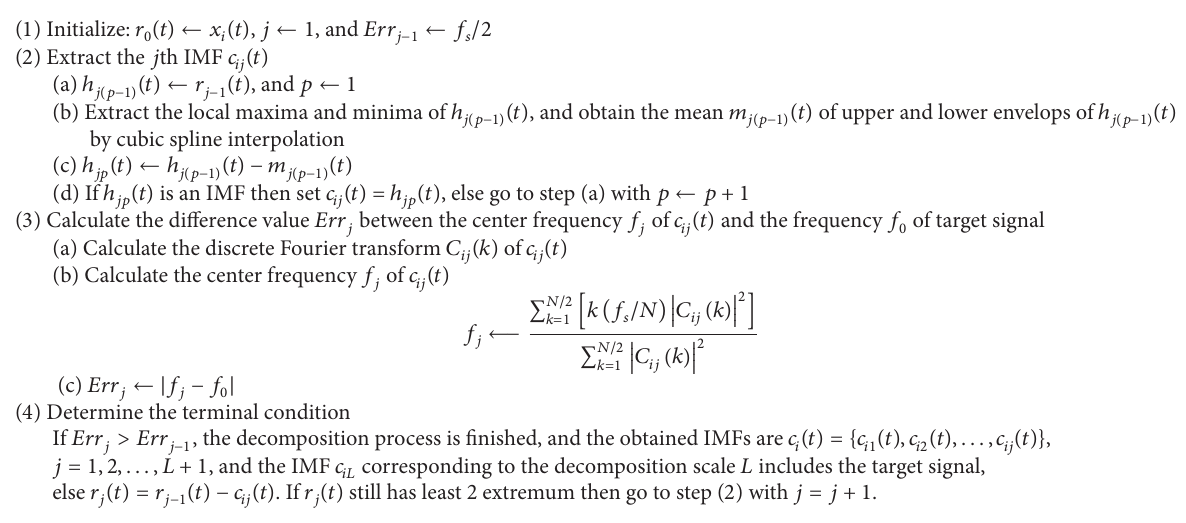
Algorithm 1: The algorithm of modified